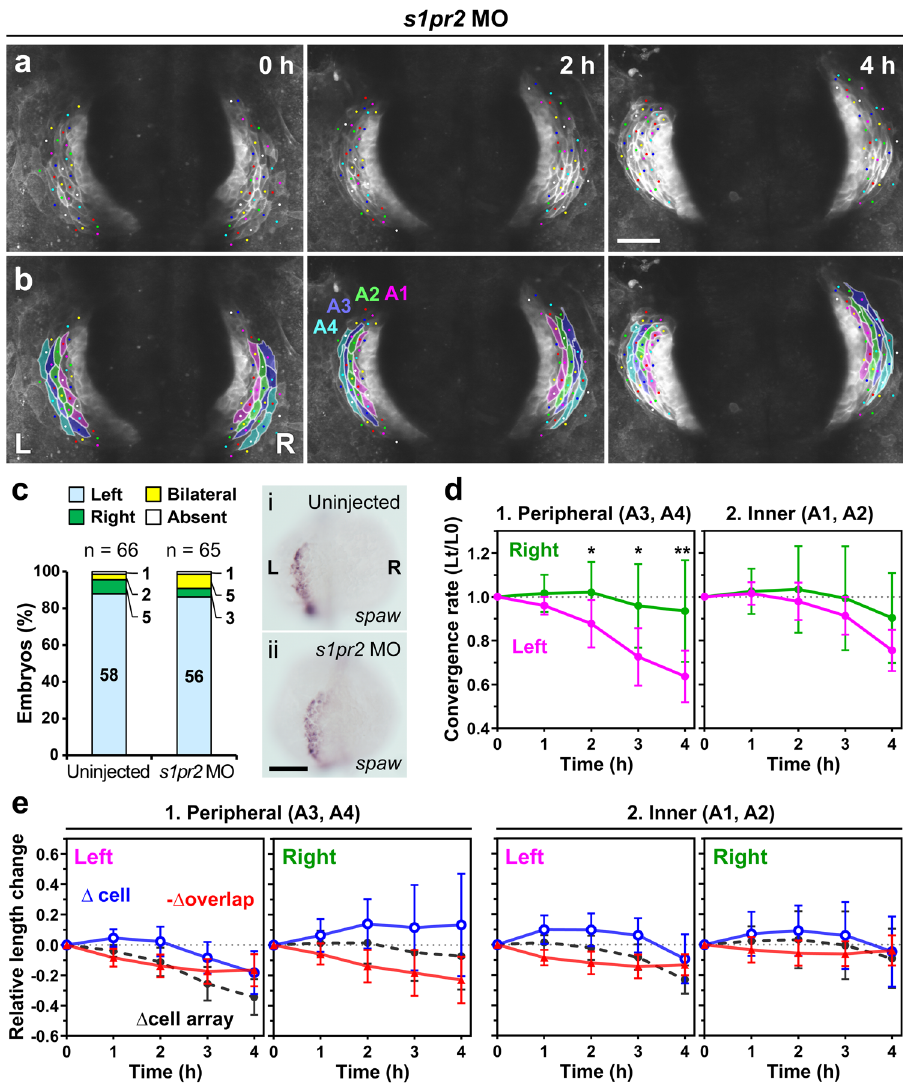
Fig. 6 Left-right asymmetric convergence occurs independently of mechanical bias caused by heart rotation. a , b Embryos with cardia bi fi da were created by injecting s1pr2 MO, which inhibits endoderm convergence and subsequent heart primordia fusion. Asymmetric convergence still occurred in the two hearts. a Selected images from a confocal time-lapse recording of a s1pr2 MO-injected Tg(myl7:EGFP-CAAX) ncv536Tg embryo starting at 19 – 20 hpf (Supplementary Movie 6). Dorsal view (anterior to the top). Scale bar = 50 µ m. b Colored, corresponding images to those in a . Four cell arrays are labeled with different colors (A1 – A4). c spaw mRNA expression in uninjected (i) and s1pr2 MO-injected (ii) embryos was assessed by in situ hybridization. The bar graph shows percentage of control (uninjected siblings, n = 66) and s1pr2 MO-injected embryos ( n = 65) with left-sided, right-sided, bilateral, or absence of spaw expression in the lateral plate mesoderm (LPM). Morpholino injection did not perturb the normal left-sided spaw expression in the LPM. Scale bar = 200 µ m. d Plots of the relative lengths (Lt/L0) of peripheral (1) and inner (2) cell arrays in s1pr2 MO-injected embryos (cardia bi fi da). The left cell arrays in the peripheral region (A3 and A4) converged more rapidly than the right ones, whereas no signi fi cant difference was observed between the left and right cell arrays in the inner region (A1 and A2), similar to that as in normal embryos shown in Fig. 5. * p < 0.05, ** p < 0.01, *** p < 0.005 (two-tailed t - test assuming unequal variances, n = 4 embryos). Means ± s.d. are shown. e Relative length changes of cell arrays (black), cells (blue), and loss of the cell lengths caused by the cell overlap (red) in the peripheral (1) and inner (2) cell arrays in s1pr2 MO-injected embryos. n = 4 embryos. Means ± s.d. are shown. For d , e , corresponding graphs indicating individual data points are shown in Supplementary Fig.